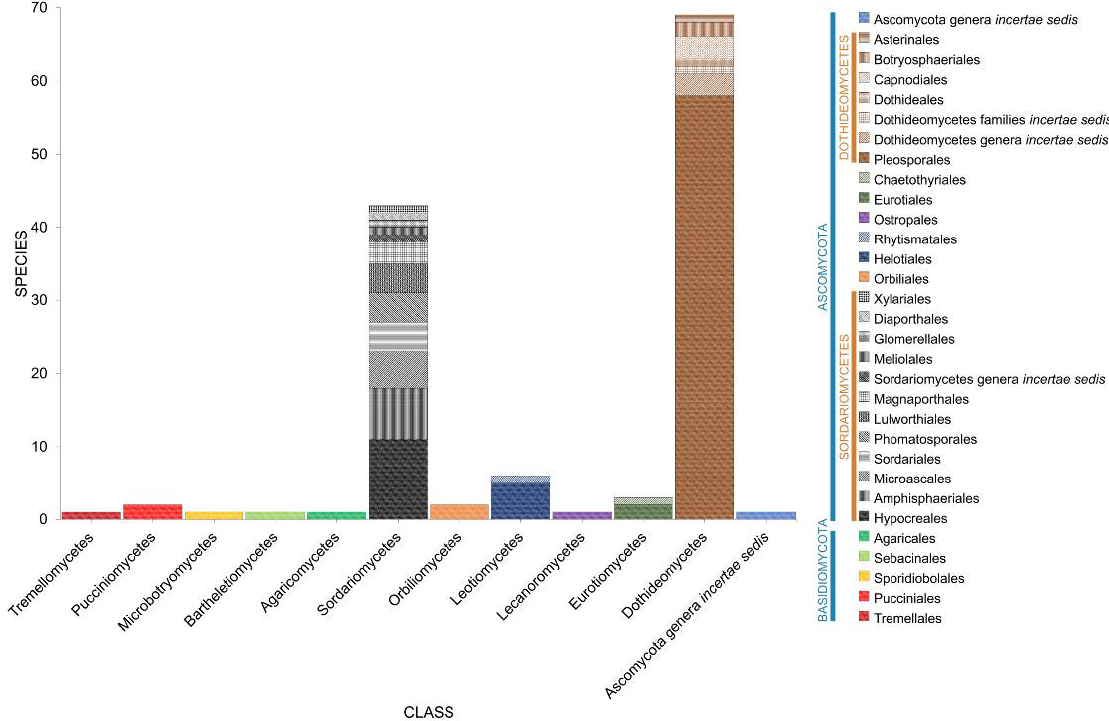
Figure 12. The distribution of fungal taxa associated with Phragmites